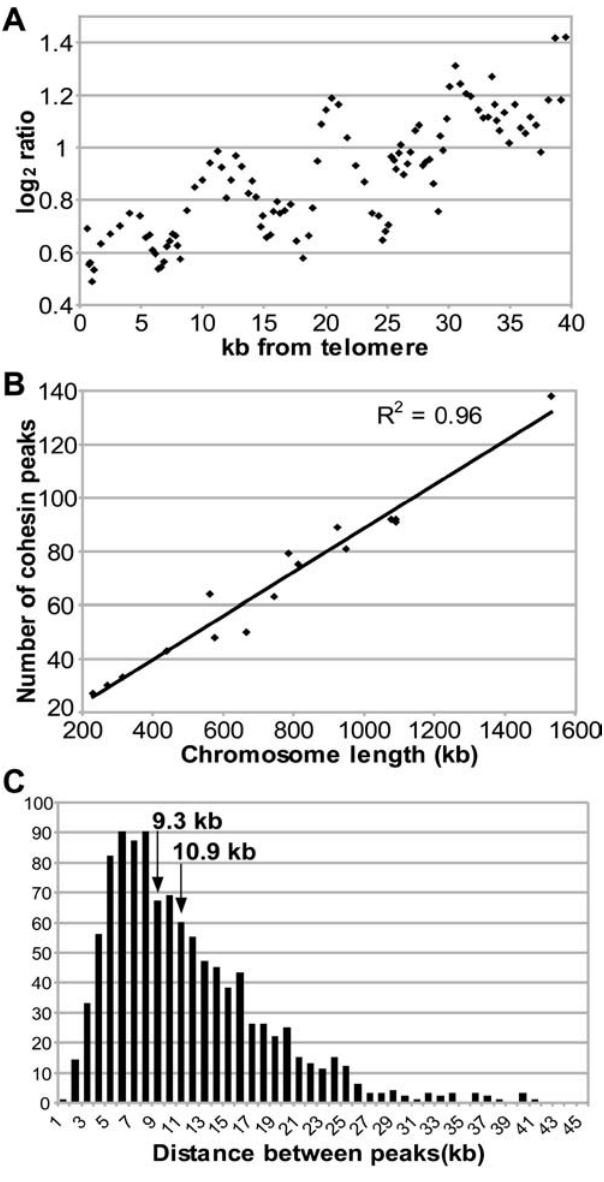
Figure 3. Features of Peaks (A) Using all cohesin-binding peaks within 40 kb of a telomere ordered based on distance from the telomere, we calculated a five- point moving average for distance in kilobases from the telomere (x- axis) and plotted this as a function of the five-point moving average of the log 2 value for the associated peaks (y-axis). (B) Chromosome length (x-axis) is plotted as a function of the number of cohesin peaks (y-axis). A line was fitted using the least squares method and R 2 ¼ 0.96. (C) The distance between peaks was put into 1-kb bins; the average distance between peaks is 10.9 kb and the median is 9.3 kb. DOI: 10.1371/journal.pbio.0020259.g003